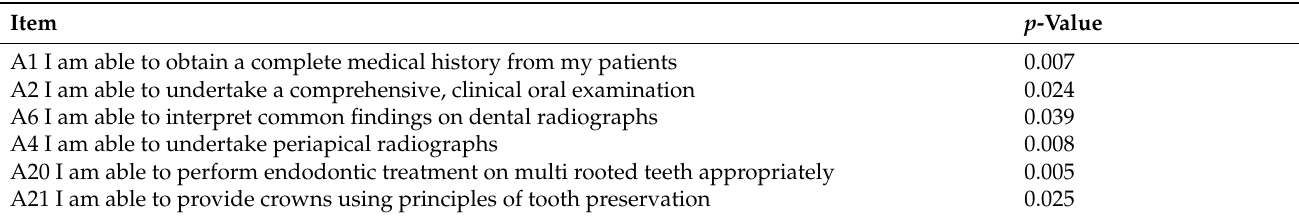
Table 3. Association between Institution Type and Item Responses for Part A. Specific p -values from Chi-Squared tests of association for items showing a statistically significant association between Institution Type and Item Responses for Part A.